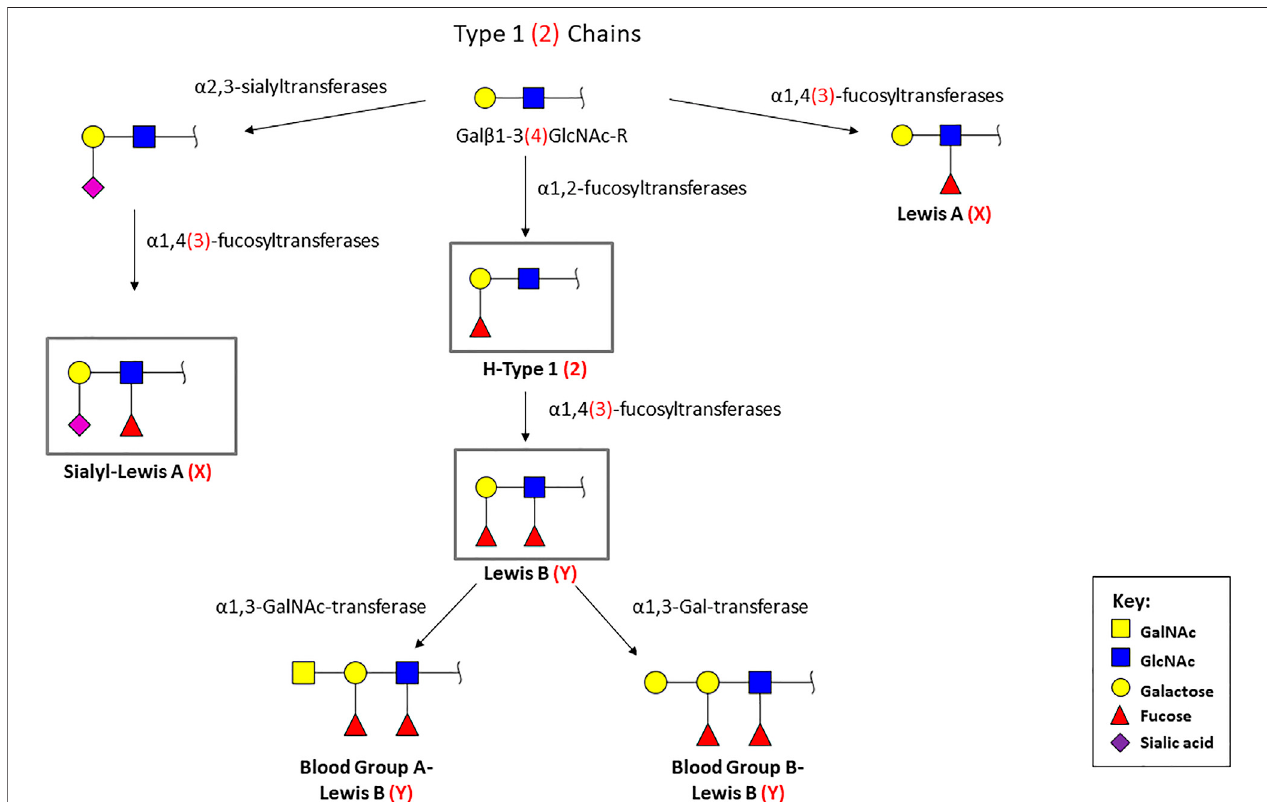
FIGURE1| Biosyntheticpathwayoftheterminalhisto-bloodgroupantigens[ABO(H)].Type1chainsarecharacterizedbytheGal β 1,3GlcNAclinkage(represented in black), while type 2 chains display a Gal β 1, 4GlcNAc linkage (represented between parentheses and in red). Monosaccharide symbols follow the Symbol Nomenclature for Glycans (Neelamegham et al., 2019). The antigens signed in the grey box (LeB, H-type 1, sLeA, and sLeX) are the structures recognized by H. pylori BabA and SabA adhesins.